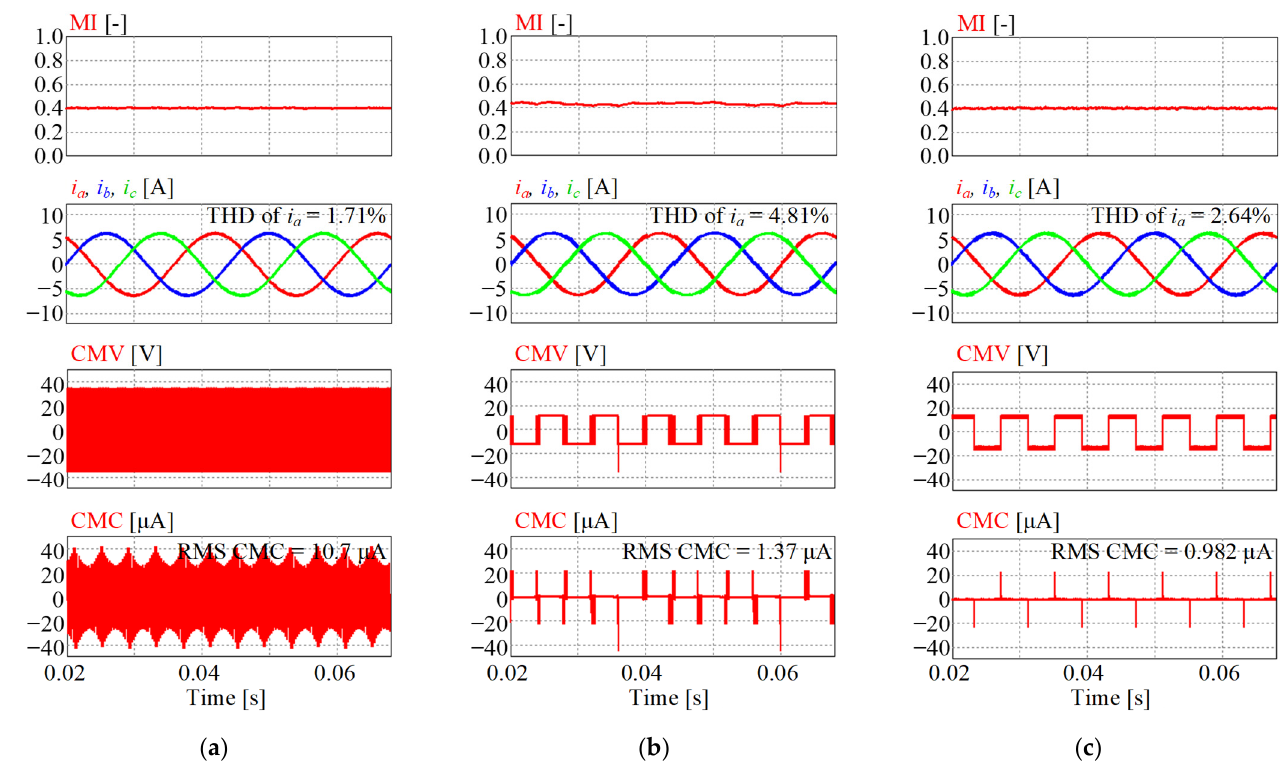
Figure 13. Comparison of simulation results of three-phase current, CMV, and CMC at rated load current and rotor speed of 500 rpm (MI = 0.4): ( a ) Standard SVPWM; ( b ) MRSPWM; ( c ) Proposed method.